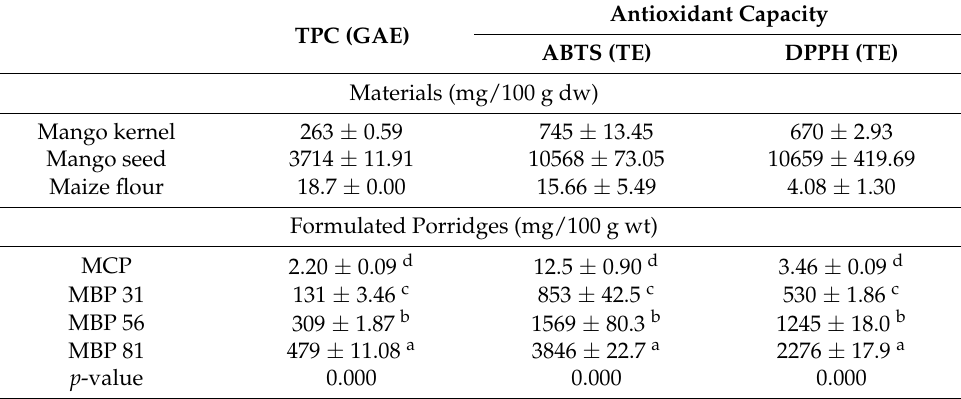
Table 5. Total phenolic content and antioxidant capacity of mango by-products, maize flour, and formulated composite porridges. The results are expressed as mean ± SD. Different lower-case letters represent statistical differences. TPC